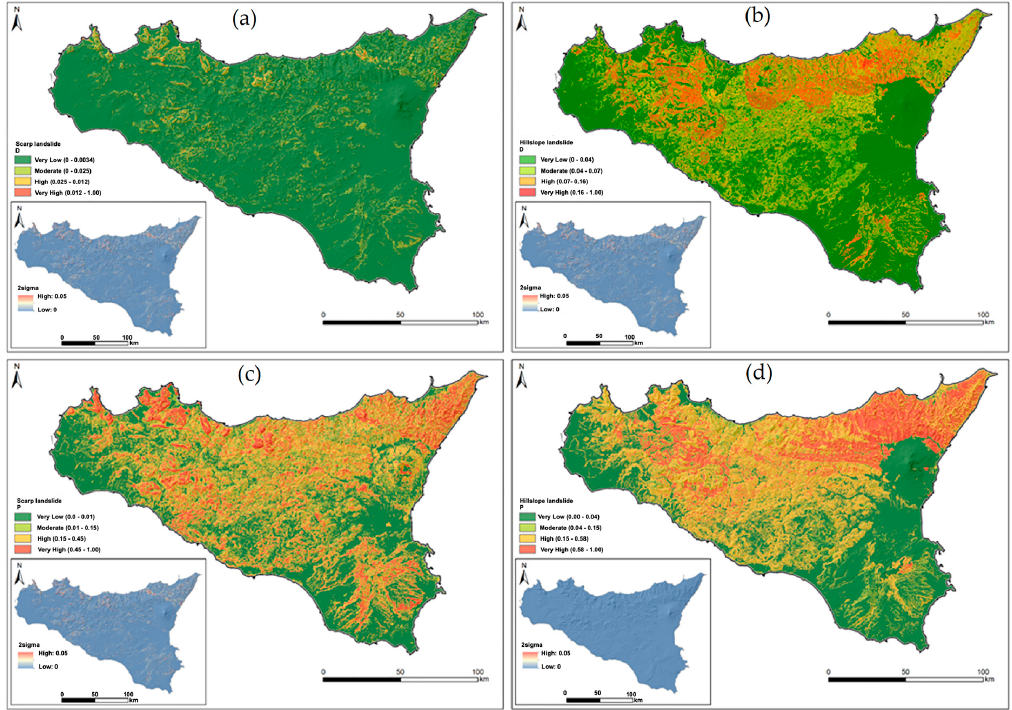
Figure 5. Susceptibility distribution for HILL_LSN using CA ( a ) and BLR analysis ( b ); susceptibility distribution for SCR_LSN using CA ( c ) and BLR analysis ( d